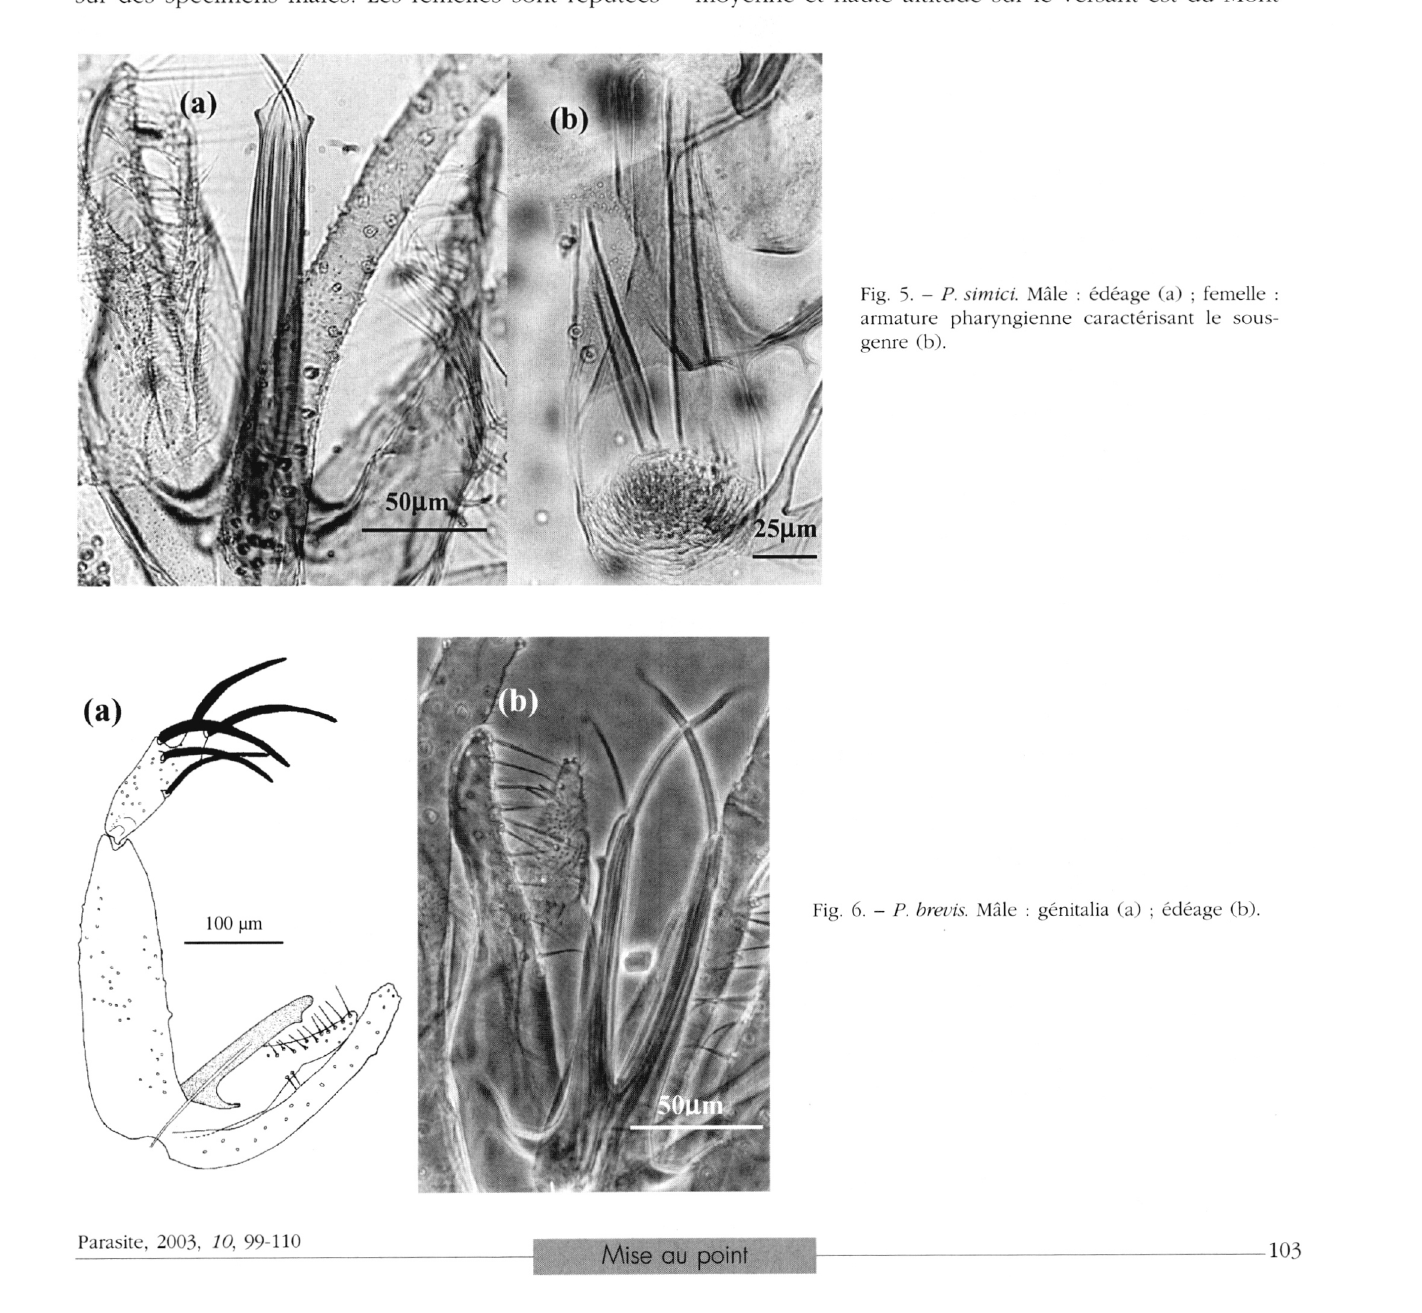
Fig. 5. - P. simici. Mâle : édéage (a) ; femelle : armature pharyngienne caractérisant le sous- genre (b).